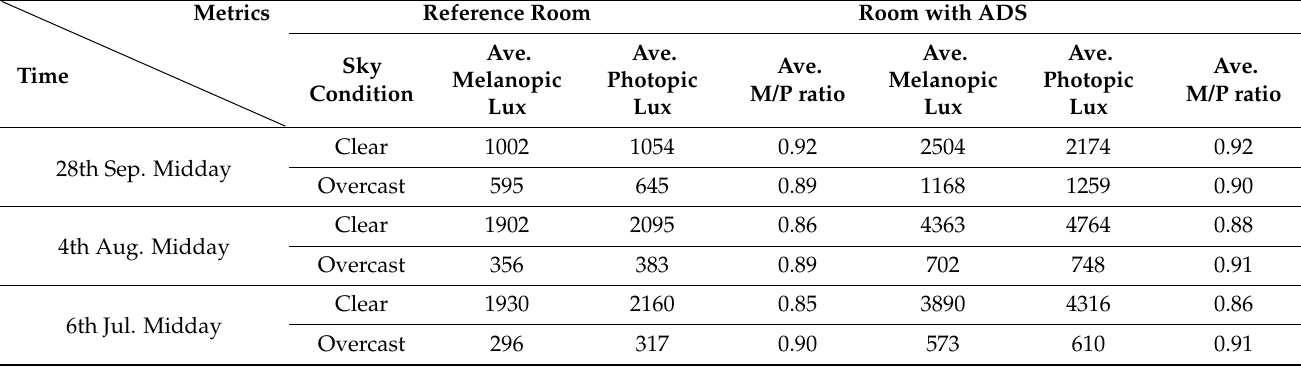
Figure 20. Incoming daylight spectrum for Sydney, NSW, under clear sky conditions. Table 5. Melanopic and photopic lux study for the case